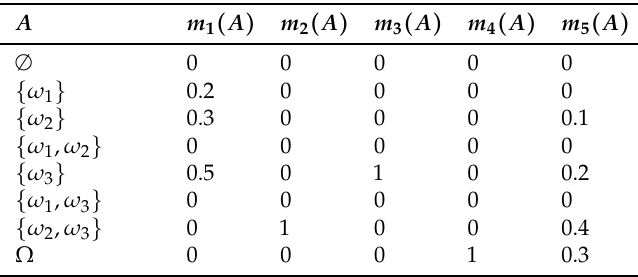
Table 2. Example of the evidential